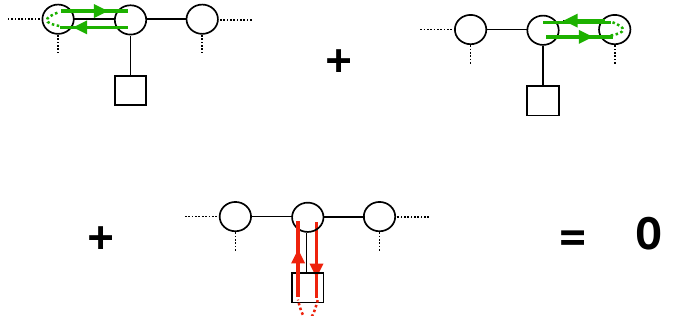
Figure 3 . Two chiral operators on the Higgs branch of the magnetic quiver of theory B. The open string operator (in red) is in the bifundamental of the (cid:13)avor group U(2) (cid:2) U(1), while the closed string operator (in green) is a (cid:13)avor singlet. Both contain marginal superpotential deformations since they have length=4, and hence belong to B 1 [0] (2;0) 2